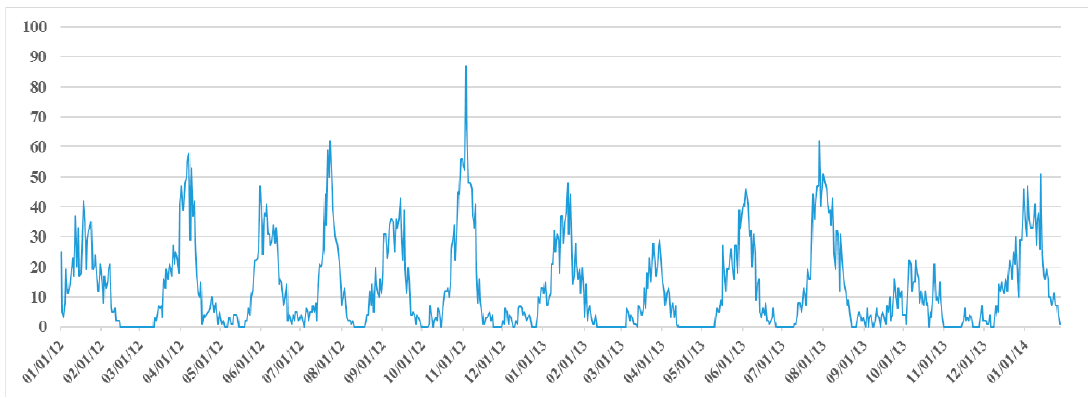
Figure 8. Time distribution of remote sensing data.